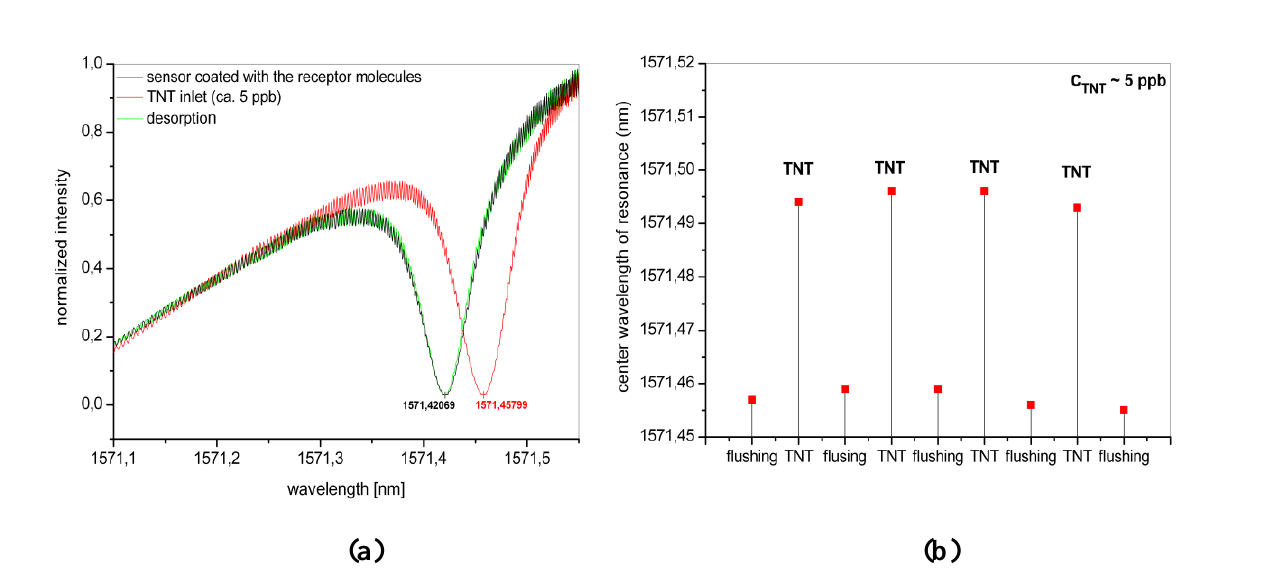
Figure 4. Wavelength shift of resonance measured after the inlet of TNT (a) and for several consecutive flows of TNT